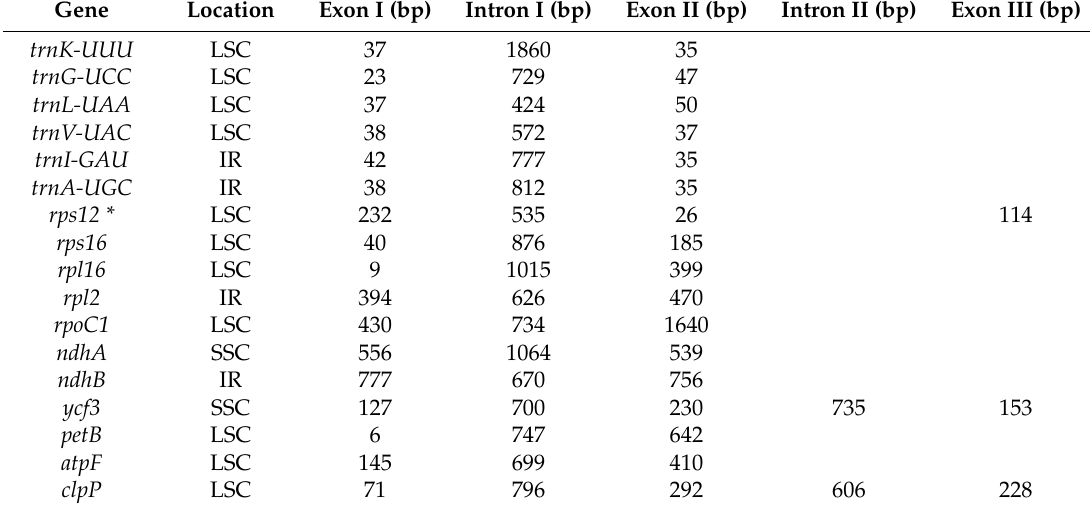
Table 3. The length of exons and introns in genes with introns in the A. annua chloroplast genome.